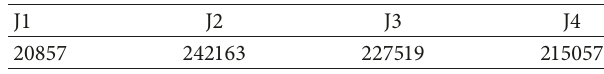
Table 9: Transfer cost of relief goods from reliable distributor to